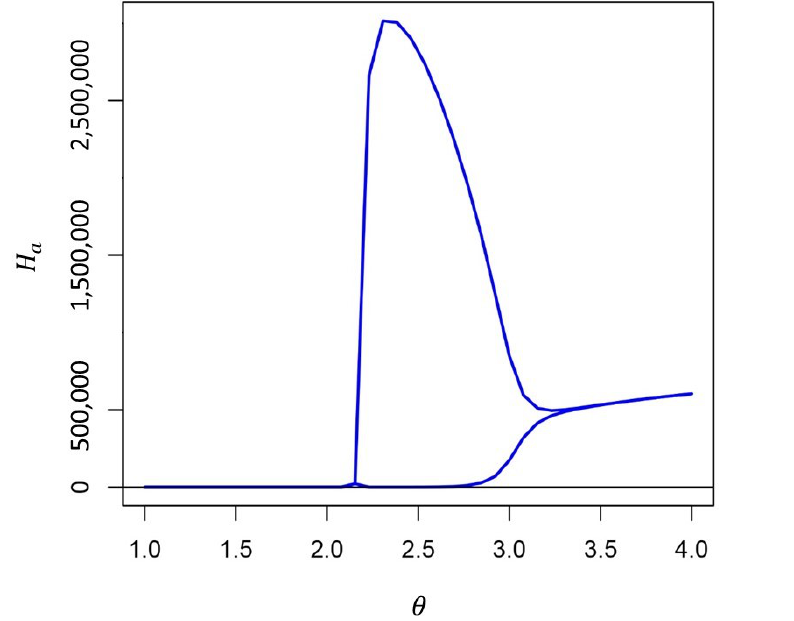
Figure A4. Amplitude of solutions in the Full Model at 10,000 days. The supercritical Hopf bifur- cation appears near θ = 2.2. For large enough θ the periodic solutions disappear through another supercritical Hopf bifurcation (eigenvalue analysis not shown). These results were obtained from the same parametrization as Figure